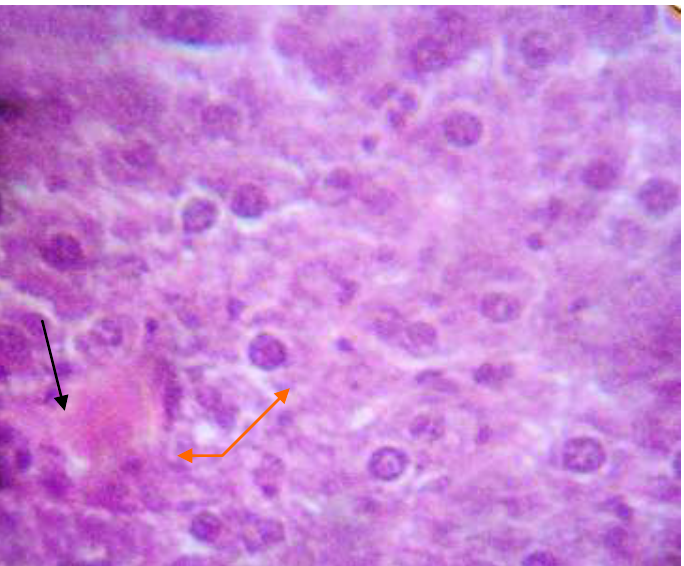
Figure (5): histological section of liver from the 1 st group showing congested central vein surrounding by hepatocyte which appeared enlarged, degenerated and some are necrotized. (H&E: X200)